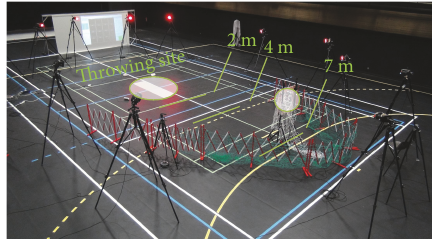
Figure 2: Experimental setup. The setup consisted of a throwing site and a target that could be placed at 2, 4, and 7 m from the thrower. Motion capture was done thanks to 16 cameras, and EMG measurements were done through a wireless EMG